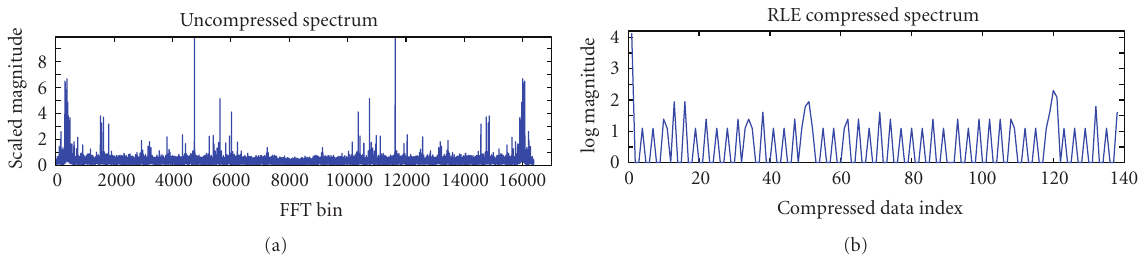
Figure 14: (a) Output from 16 k FFT of data captured from the FORTE satellite. (b) The same data compressed using the Gabor compression scheme with Run-length